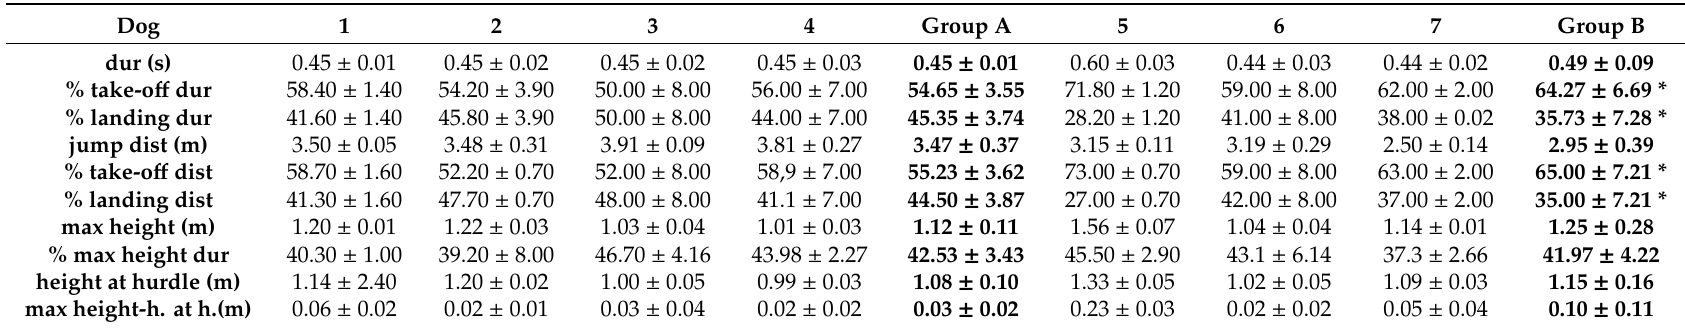
Table 2. Results (mean ± standard deviation) of temporal and linear variables of seven agility dogs jumping over a 60-cm hurdle. In bold results of Group A, dogs ranked as excellent jumpers competing in the greater level (level 3) and of Group B, dogs ranked as less-skilled jumpers and of a lower level in the competition (level 2). Jump distance was measured based on the withers position from take-o ff to landing. *, significant di ff erences by a Mann–Whitney U test ( p < 0.05). Dog